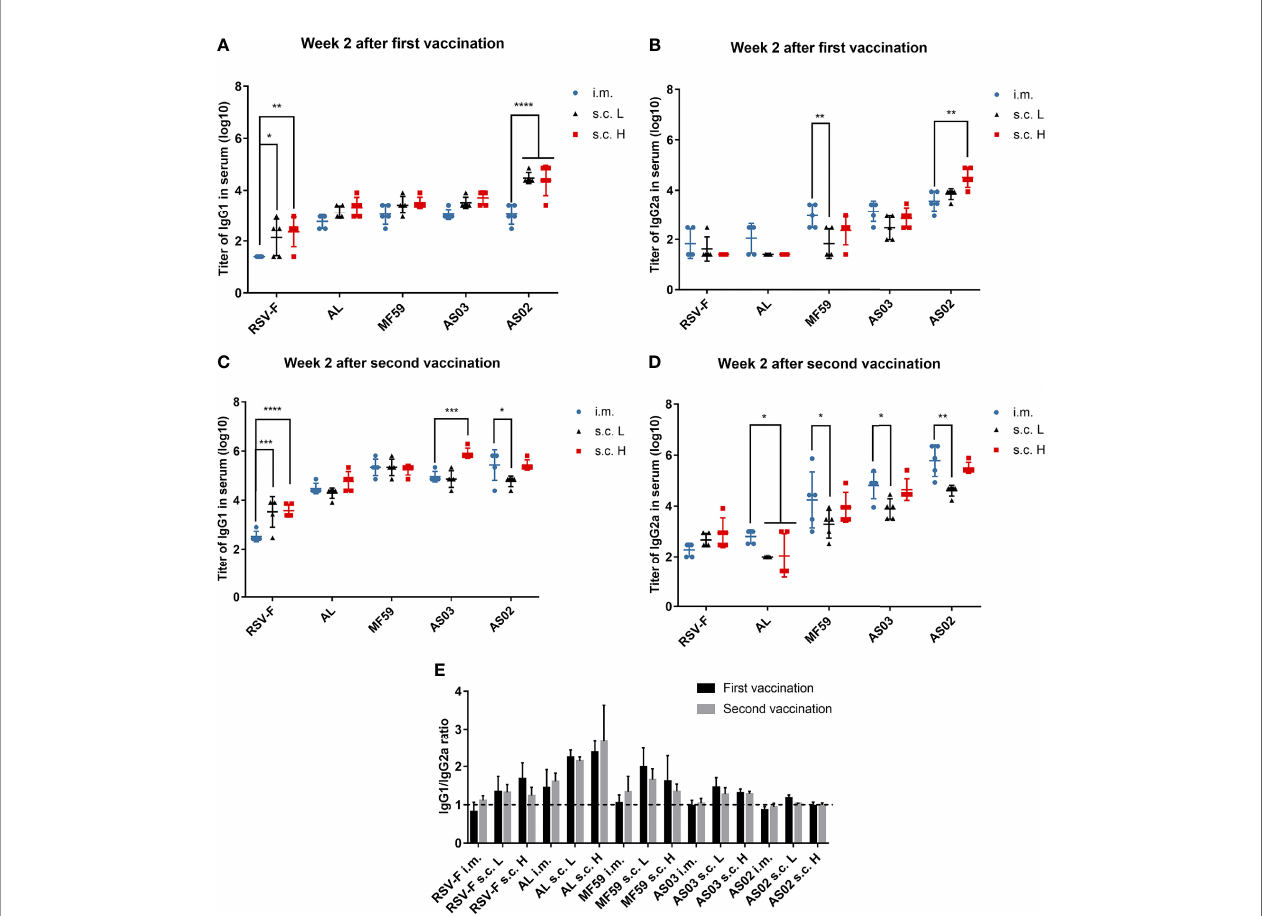
FIGURE 4 | RSV-F-speci fi c IgG1 and IgG2a antibodies and IgG1/IgG2a ratios. Sera from mice primed (A, B) and boosted (C, D) with various adjuvanted RSV-F vaccines or RSV-F alone were assessed by ELISA for their RSV-F-speci fi c IgG1 and IgG2a antibodies. The ratios of IgG1 to IgG2a for each mouse were also calculated (E) . The dashed line indicated IgG1/IgG2a ratio= 1. Data represented the mean ± SD of each group (n=5). *P< 0.05, **P <0.01, ***P< 0.001, ****P<0.0001 (two-way ANOVA with Tukey ’ s multiple comparisons